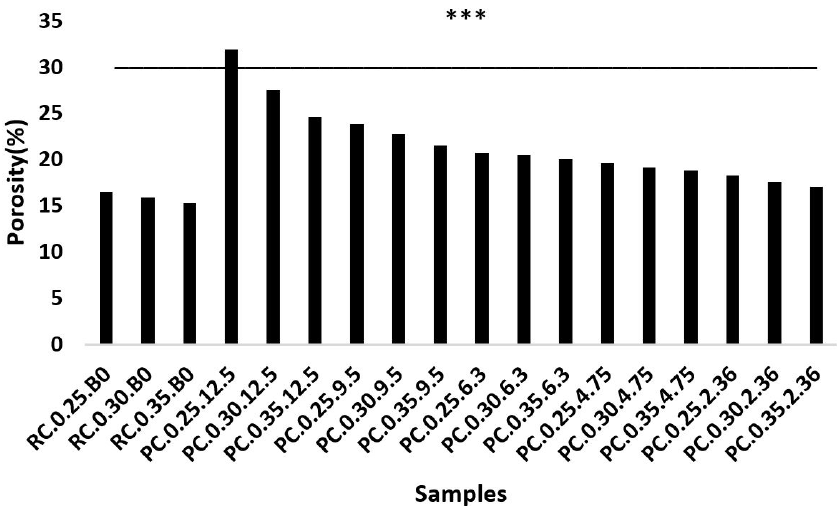
Figure 5 A verage samples results of porosity tests. *** Significant statistical difference by the Tukey test p <0.001.